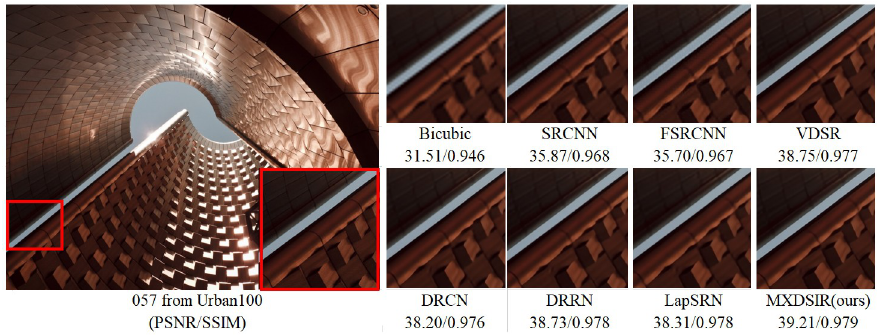
Fig 5. Visual performance of images with 4 × enlargement factor of image 057 from Urban100 dataset.